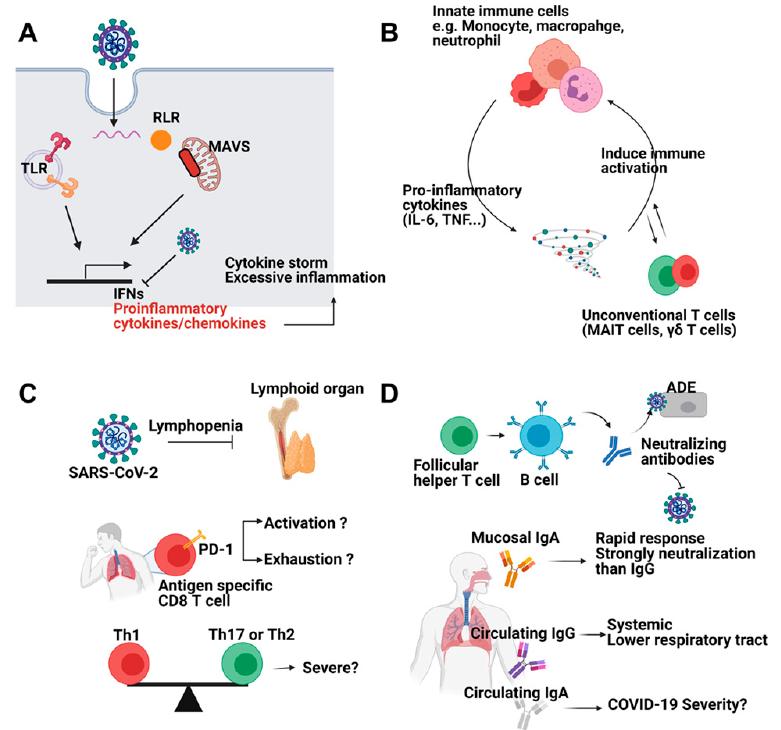
Figure 1. Immune responses against SARS-CoV-2 infection. ( A ) SARS-CoV-2 can be sensed by pattern recognition receptors (PRRs) such as Toll like receptors and RIG-I like receptors. Viral sensing induces interferons and proinflammatory cytokines and chemokines. However, SARS-CoV-2 inhibits induction of interferons. Reduced interferons and excessive proinflammatory cytokines cause cytokine storm and severe inflammation. ( B ) Innate immune cells including monocyte, macrophage, and neutrophils are the main source of proinflammatory cytokines such as IL-6 and TNF. Cytokines further activate immune cells. Unconventional T cells (MAIT cells, γδ T cells) also participate in positive feedback loop of inflammation. ( C ) SARS-CoV-2 infection leads to lymphopenia. CD8 T cells from COVID-19 patients showed exhausted feature. Whether these features represent activation or exhaustion should be addressed. Furthermore, balance among CD4 T cell subsets is a critical factor for disease severity. ( D ) Antibodies from B cells neutralize virus entry. Mucosal IgA is rapidly produced and shows superior neutralizing capacity compared to systemic IgG while circulating IgA is correlated with severe disease symptoms. Circulating IgG systemically protects host from virus. Figure was created by biorender.com (BioRender, Toronto, ON,